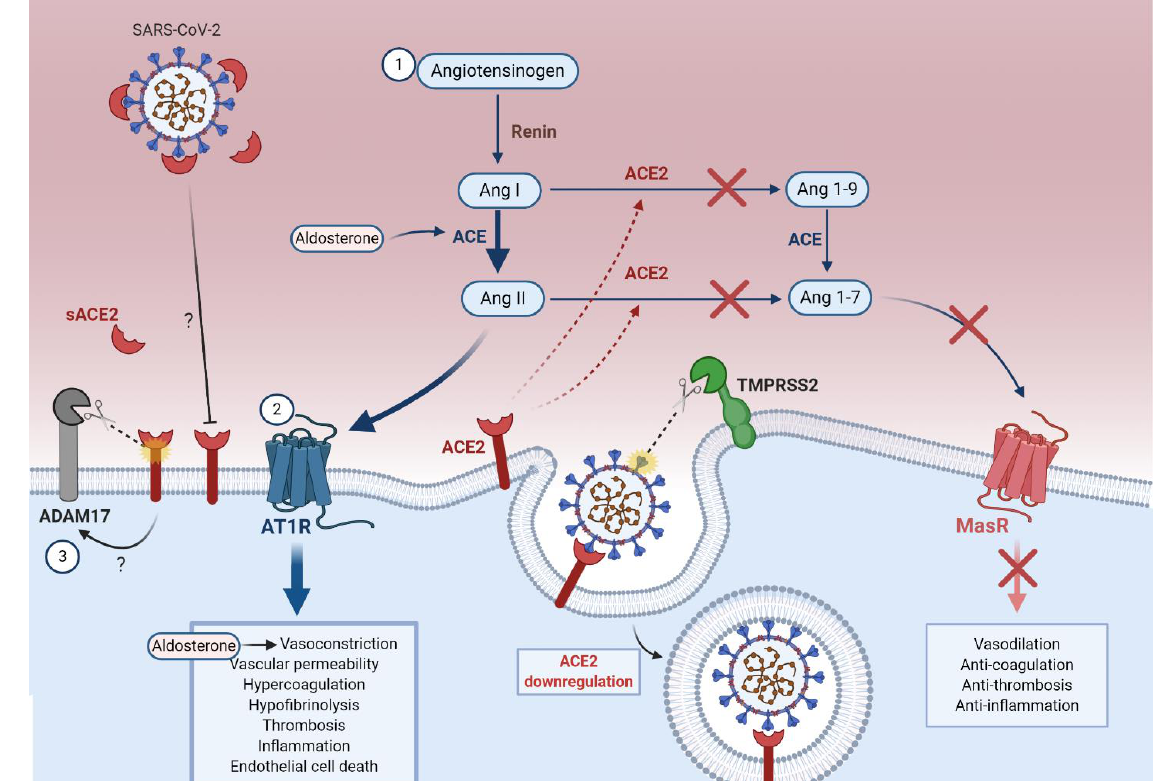
Figure 3. SARS-CoV-2-mediated cellular ACE2 downregulation leads to RAAS dysfunctions. (1) In normal conditions, the liver releases angiotensinogen, which is hydrolyzed into Ang I by renin (angiotensinogenase) from renal juxtaglomerular cells. ACE produced in the kidneys and lungs further converts Ang I into Ang II, which are then converted by ACE2 into Ang 1-9 and Ang 1-7 respectively. Ang 1-7 binds to MasR to mediate vasoprotective effects. (2) During SARS-CoV-2 infection, viral internalization results in cellular ACE2 downregulation and increased ACE. Consequently, Ang II accumulates and binds to AT1R, mediating detrimental vascular effects. (3) ADAM17 proteolytically sheds sACE2, which exacerbates inflammation, may further amplify RAAS dysfunction by decreasing cellular ACE2, and blocks SARS-CoV-2 entry.